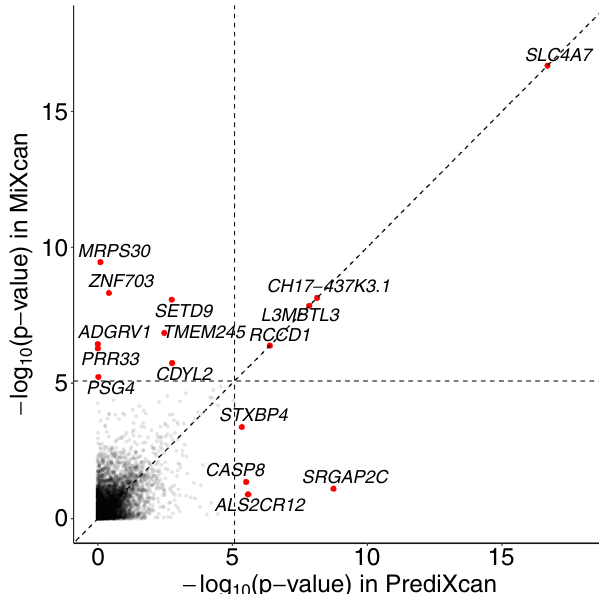
Fig. 6 | Transcriptome-wide association studies of breast cancer. MiXcan iden- ti fi ed 12 genes and PrediXcan identi fi ed 8 genes that were signi fi cantly associated with breast cancer risk at p value<7.7×10 − 6 , applying a Bonferroni correction for the6461genestestedin31,716breastcancercasesand26,932controlsofEuropean ancestry from the DRIVE study. Source data are provided as a Source Data fi